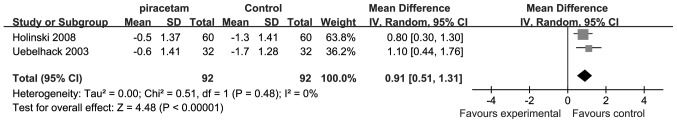
Meta-analysis variations from the baseline following treatment in the piracetam group versus the control group, relating to the immediate pictured object recall test. P<0.05 was considered statistically significant. SD, standard deviation; IV, inverse variance; CI, confidence interval.